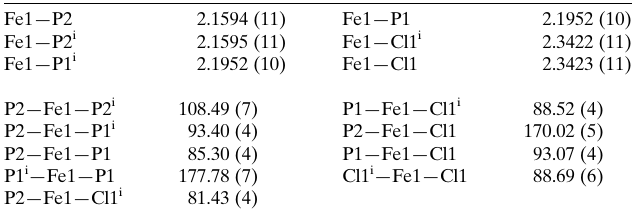
Table 2 Hydrogen-bond geometry (A˚ , (cid:3) ).